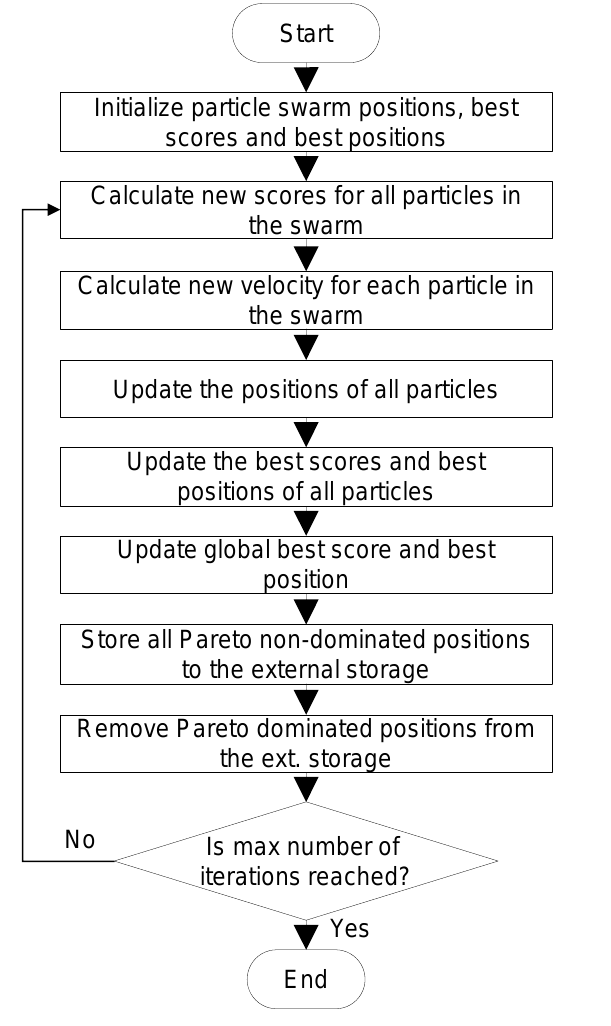
Figure 5. Flow chart of IMOPSO algorithm.